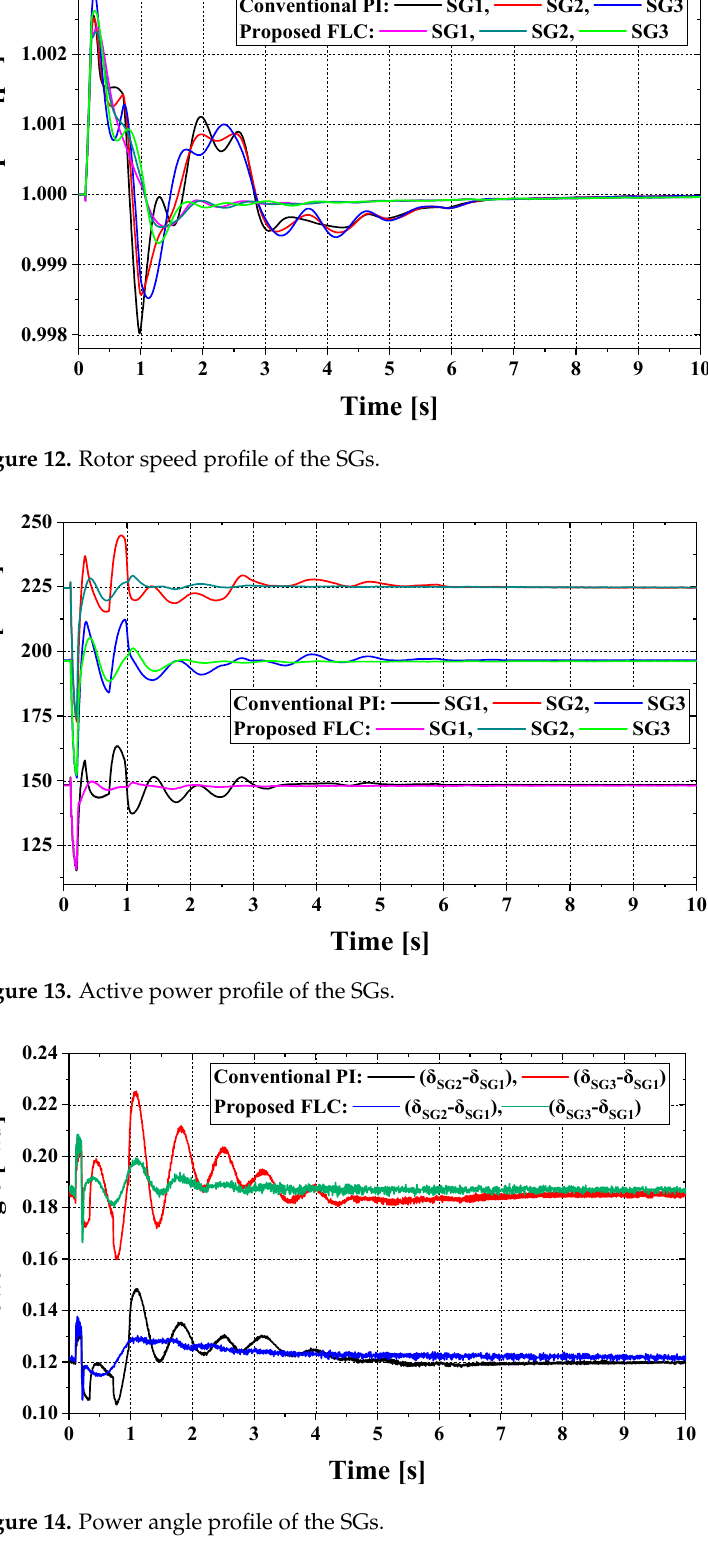
Figure 14. Power angle profile of the SGs.